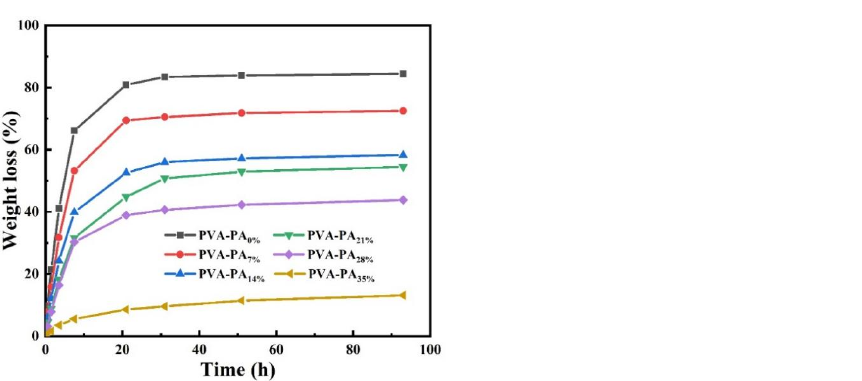
lytes of PVA-PAx hydrogels with different PA content without adding electrolytes and adding 0.05 mol L − 1 of H 2 SO 4 , KOH, and NaCl, respectively. The hydrogel electrolyte is also conductive without adding electrolyte, which may be related to the large number of